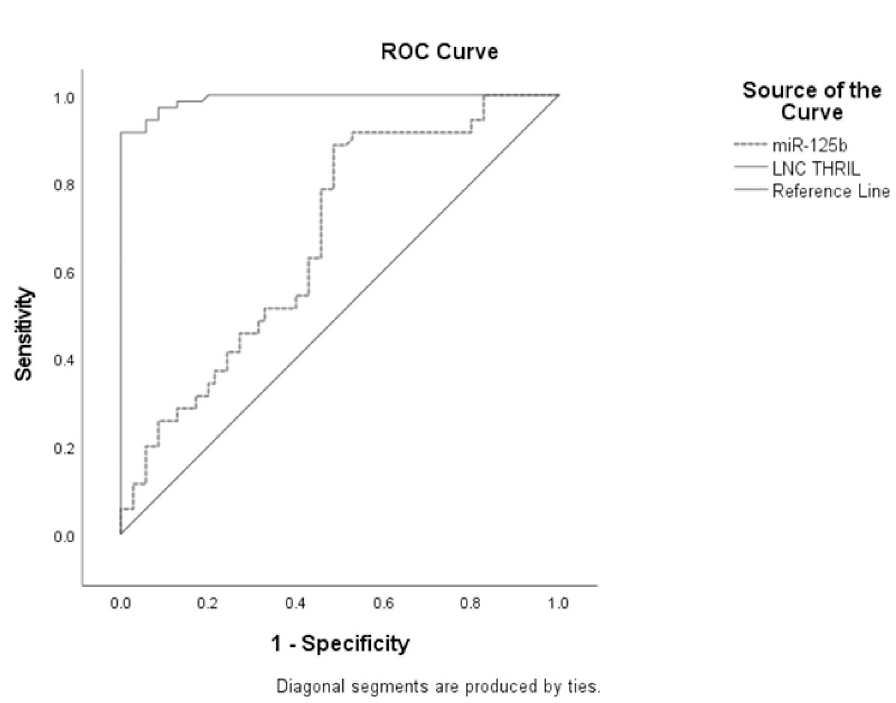
Fig 3. Receiver operating characteristic of sensitivity and specificity of Lnc THRIL and MiR-125b in UC vs. CD patients.